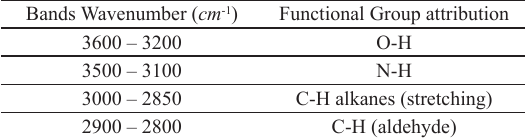
Table 3. FTIR functional groups identified in the inhibitor spectra 22,24,41